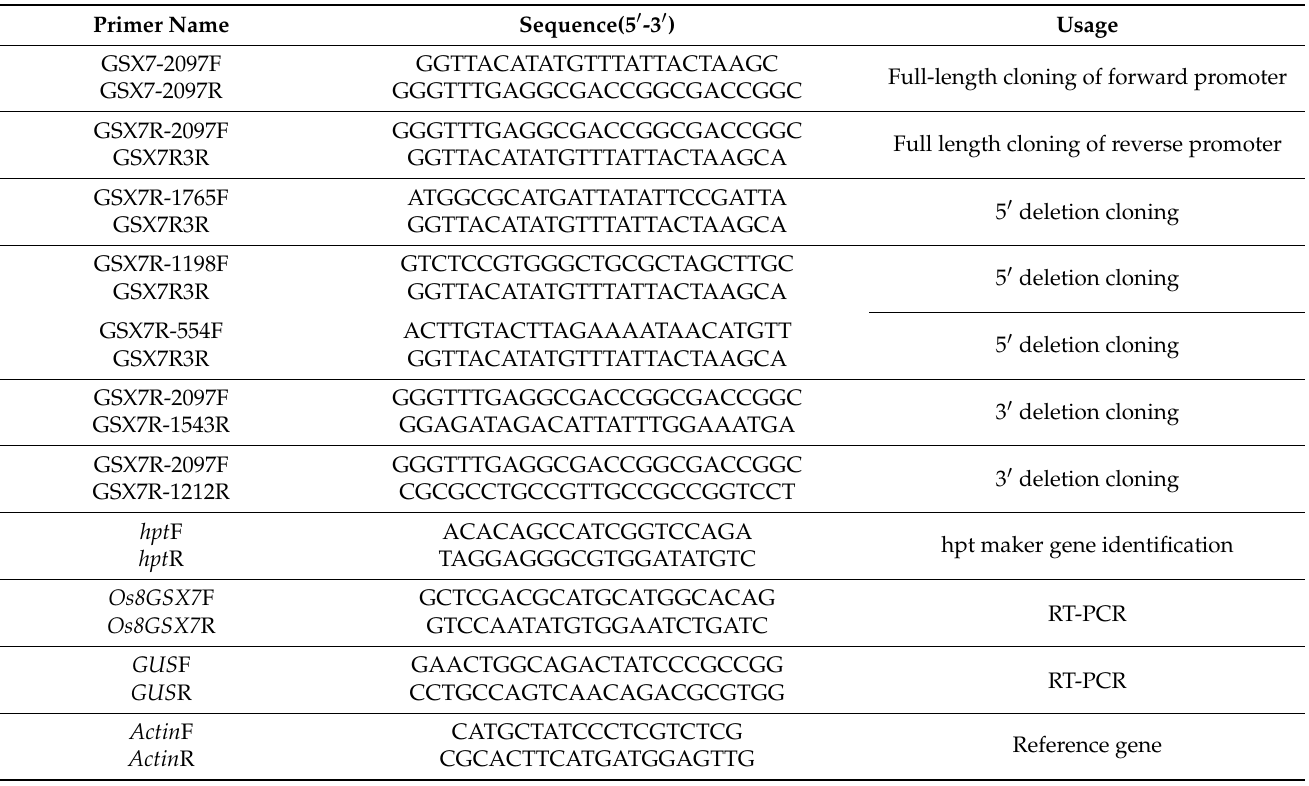
Table 1. PCR primers used in the